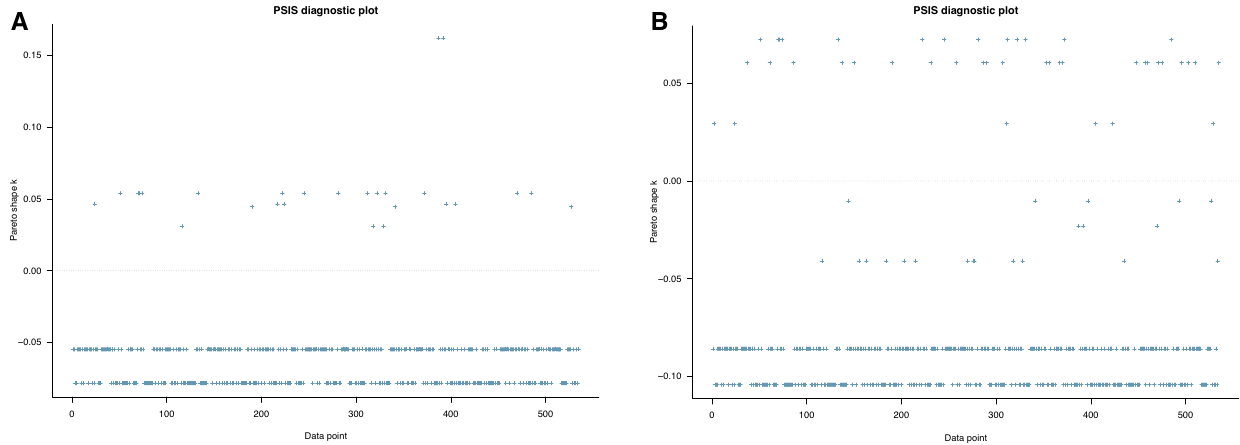
Fig. 7 PSIS-LOO diagnosis. Diagnosis for A Model 2a and B Model 2b with priors as norm (1,0.5). The model ’ s goodness-of- fi t can be classi fi ed into four levels: (1) ‘ good ’ if its k -values are all below 0.5, (2) ‘ OK ’ if its k -values are more than 0.5 and below 0.7, (3) ‘ bad ’ if its k -values are more than 0.7 and below 1, and (4) ‘ very bad ’ if its k -values are more than